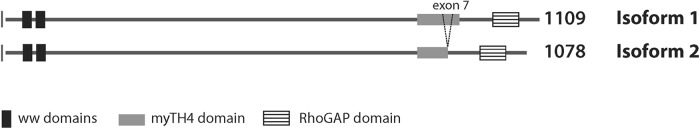
Sequences of two isoforms of Arhgap39/Porf-2 protein in mouse. The protein sequence numbers correspond to those in the NCBI database. Adapted from https://www.ncbi.nlm.nih.gov/gene/223666 (mouse). The functional domains include two WW, and one each of MyTH4 and GAP. Protein isoform 2 differs from isoform 1 in the deletion of 31 amino acids, encoded by exon 7, from the MyTH4 domain.